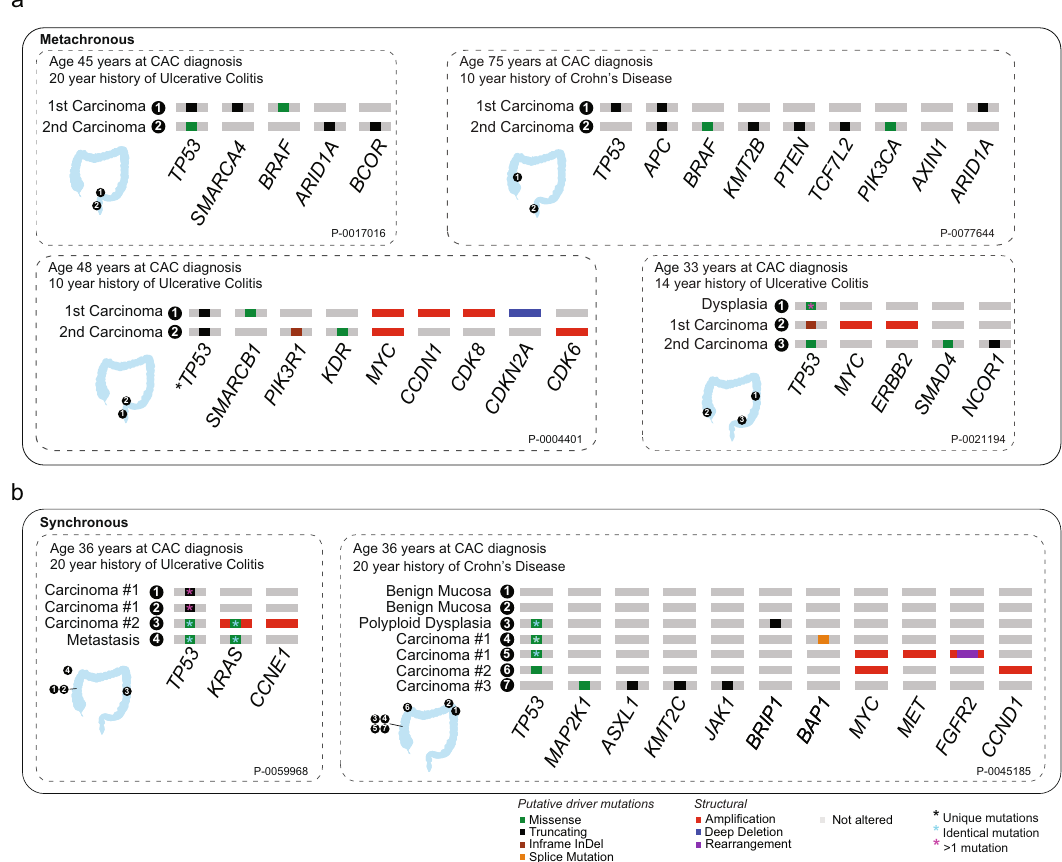
Fig. 5 | Genetic relationship of multiple primary colitis-associated cancers. Genomic analysis of multiple primaries, with illustrations showing locations of samples analyzed and oncogenic genomic alterations identi fi ed in each sample ( fi ltered by OncoKB). a Patients with metachronous primary colitis-associated cancers: fi rst row: (left) patient with rectosigmoid primary and 24 months later a new primary in the rectal remnant and (right) patient with cecal primary and 4.5 years later a new sigmoid colon primary; second row: (left) patient with sigmoid malignant stricture and 11 months later a new primary in the rectal stump and